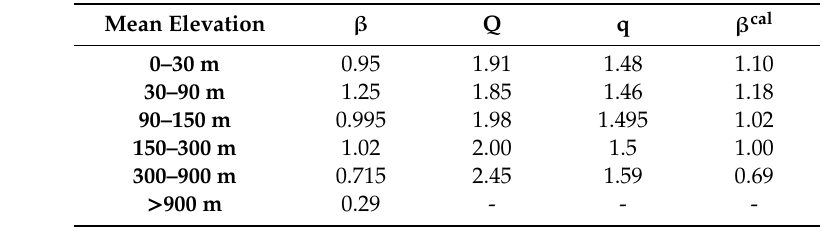
Table 1. The power law exponent β , the Q and q non extensive parameters and the β cal value as estimated for each of elevation class of Greece drainages.